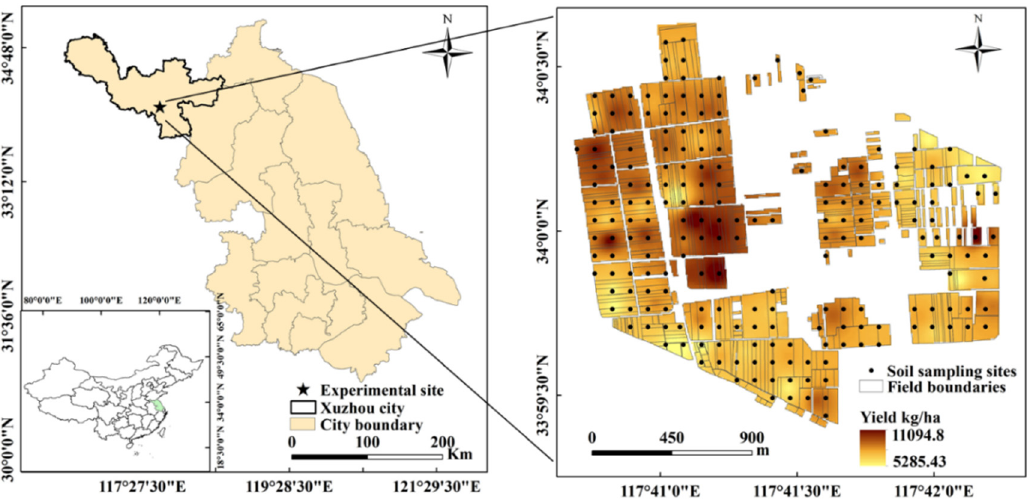
Figure 7. Location of the study area and the sampling grids used to guide soil sample collection of the experimental site (Zhaoji village, Jiangsu, China).